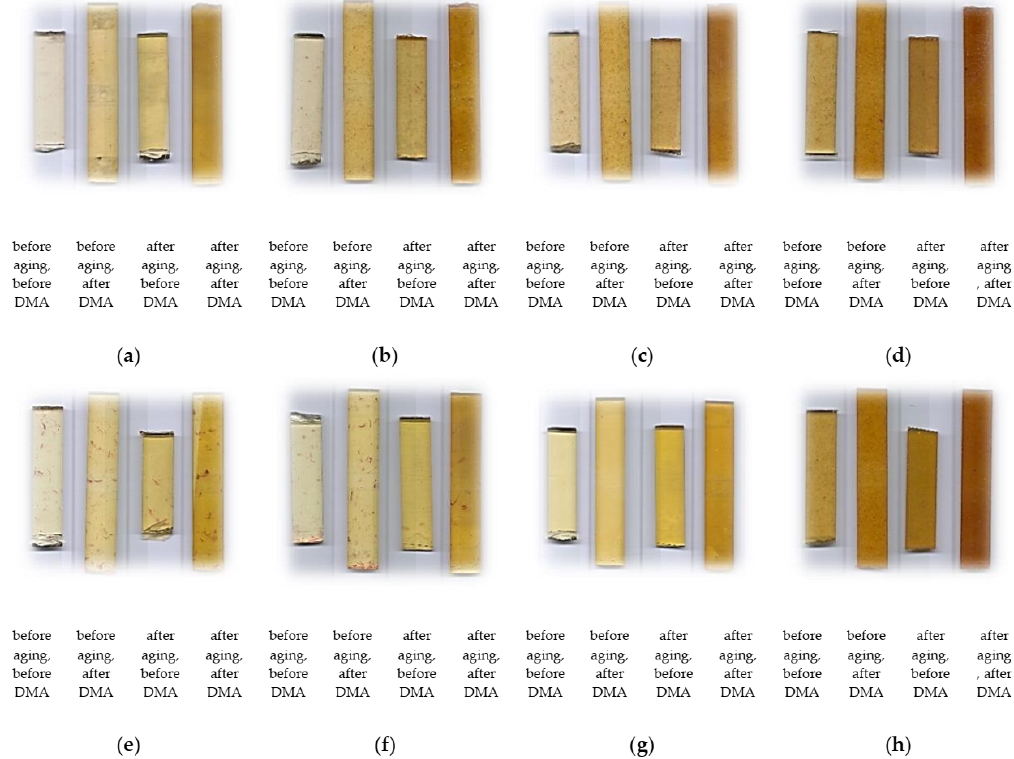
Figure 2. Samples before and after accelerated aging test and DMA. ( a ) Unsaturated polyester resin (UPR); ( b ) U + W1; ( c ) U + W2; ( d ) U + W5; ( e ) U + d0.2; ( f ) U + d0.5; ( g ) U + d1.0 and ( h ) U + W5 + d1.0.